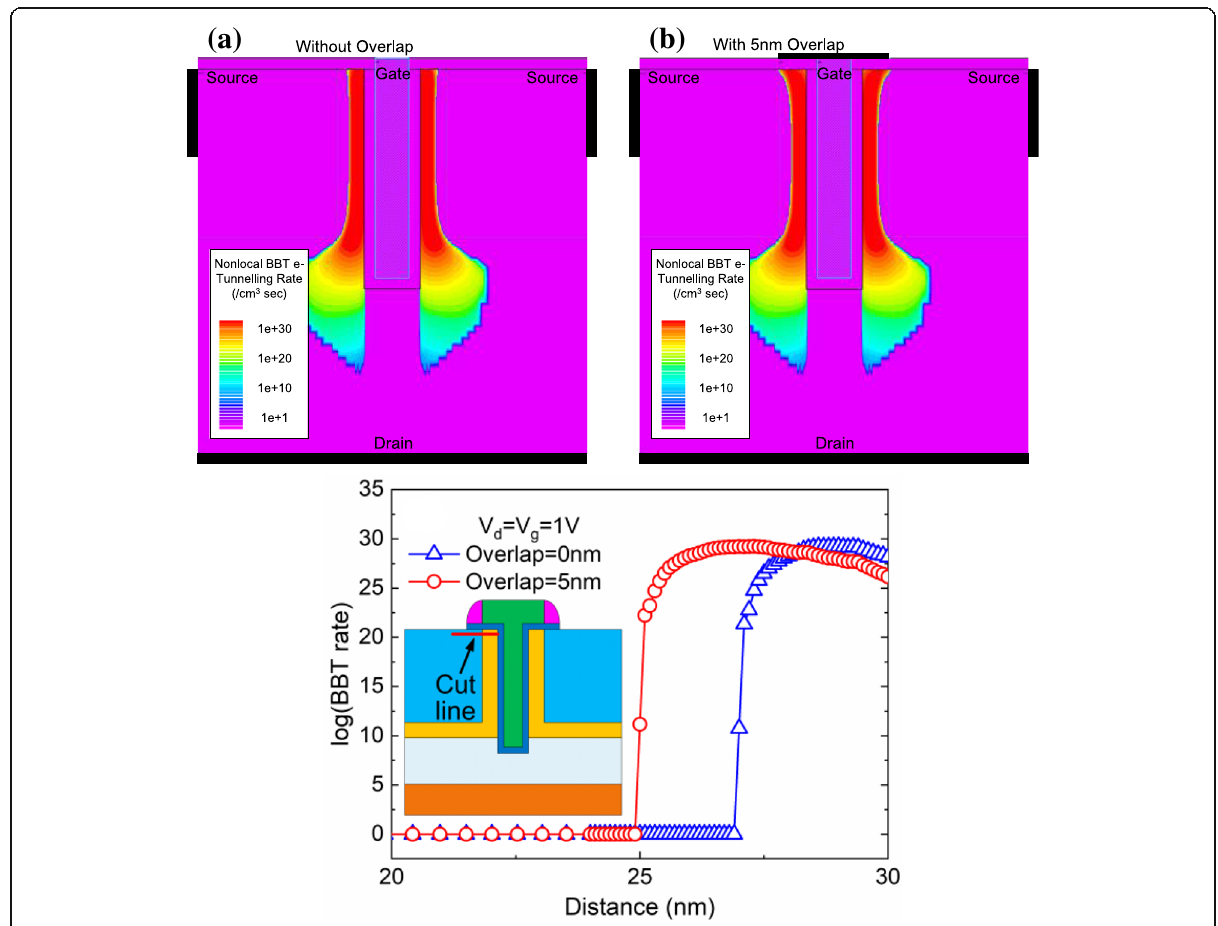
Fig. 4 Simulated BBT electron tunneling rate diagrams of a device without gate overlap, b device with 5-nm gate overlap, and c the BBT electron tunneling rate of two devices, at 1 nm below the device surface; V g = V d = 1